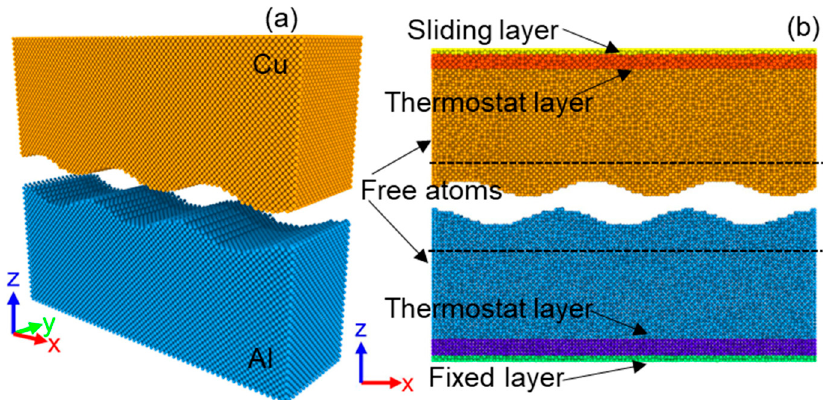
Figure 1. MD simulation model used for Al and Cu ultrasonic welding: ( a ) Initial configuration of sample; ( b ) Equilibrated configuration after relaxation under zero pressure at 300 K.